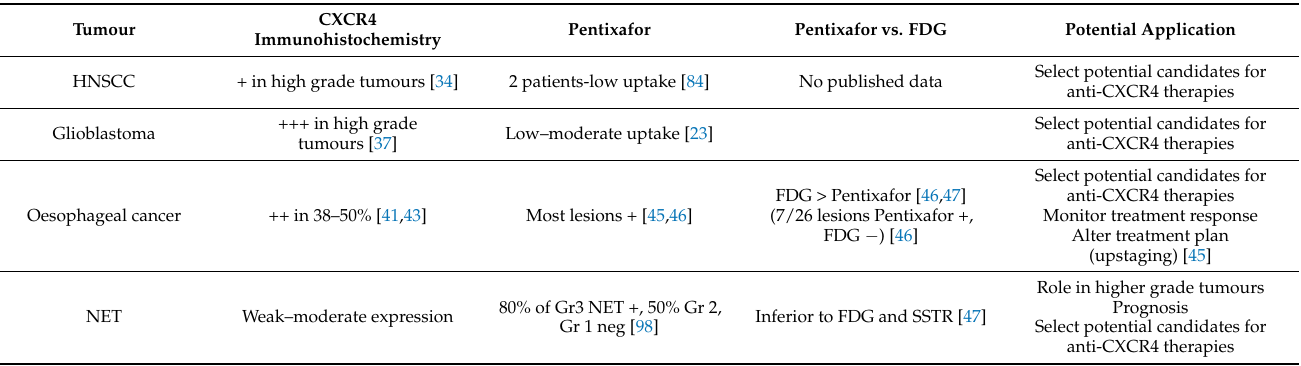
Table 1. Potential applications of CXCR4 in solid